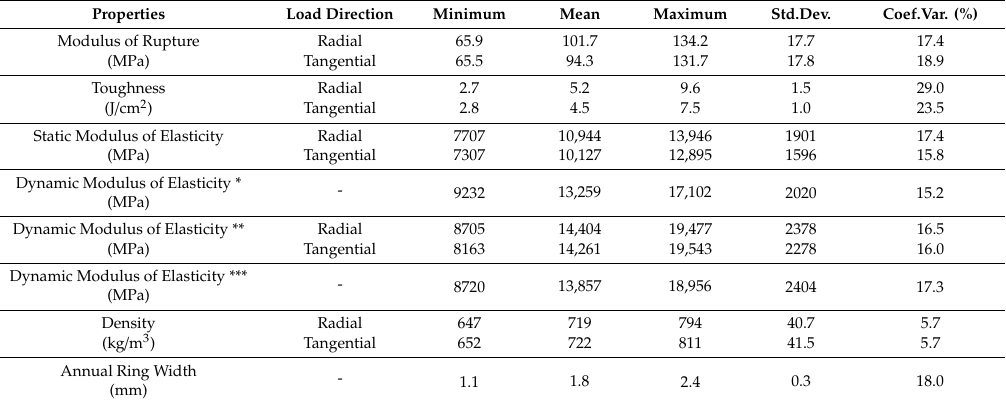
Table 6. Basic Statistical Analyses of the Properties for Oak Wood.